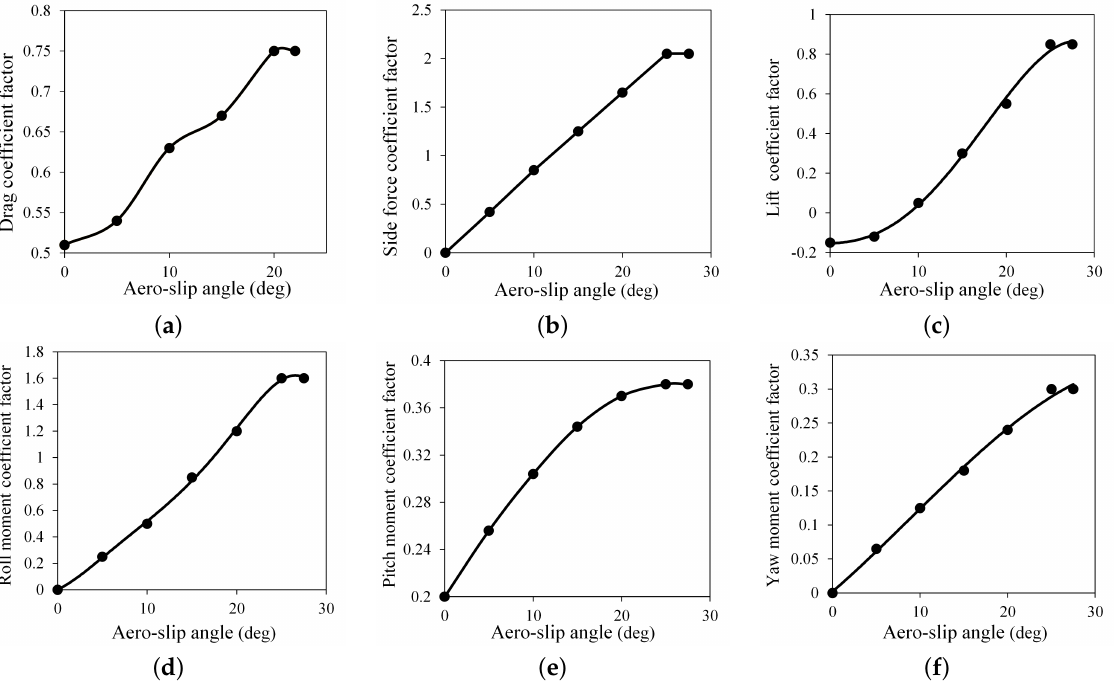
Figure 3. Six component aerodynamic force (moment) coefficient of tractor. ( a ) Drag coefficient factors, ( b ) side force coefficient factors, ( c ) lift coefficient factors, ( d ) roll moment coefficient factors, ( e ) pitch moment coefficient factors, and ( f ) yaw moment coefficient factors.